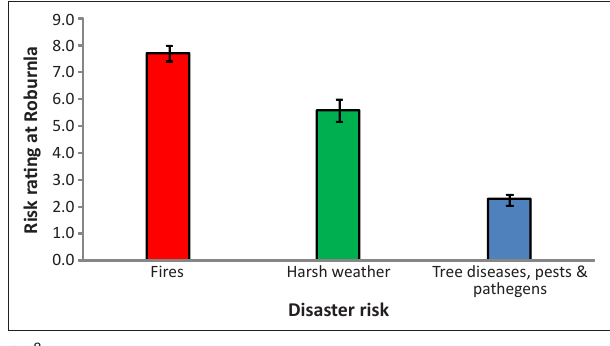
FIGURE 1: Extent of risk at Roburnia Plantation using the Wisner